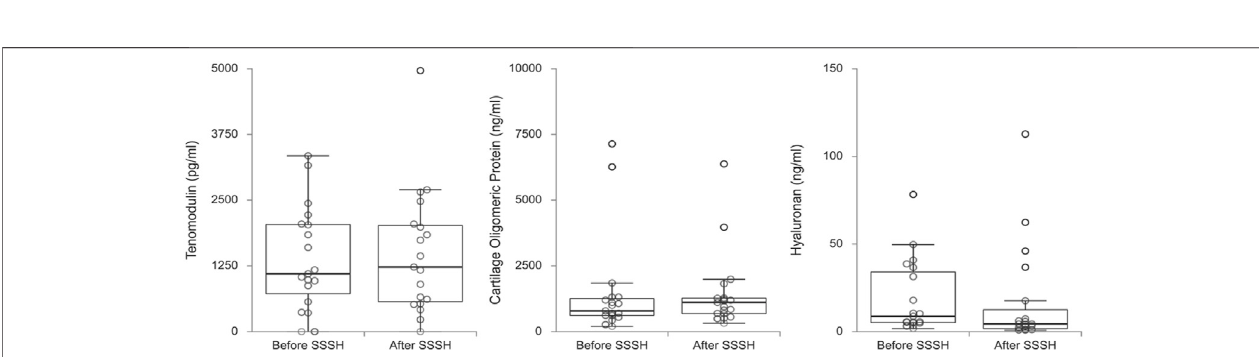
FIGURE 2 | Box plots of tendon/ligament-related (tenomodulin) and cartilage-related (cartilage oligomeric matrix protein and hyaluronan) biomarkers before and after the exercise program SSSH.